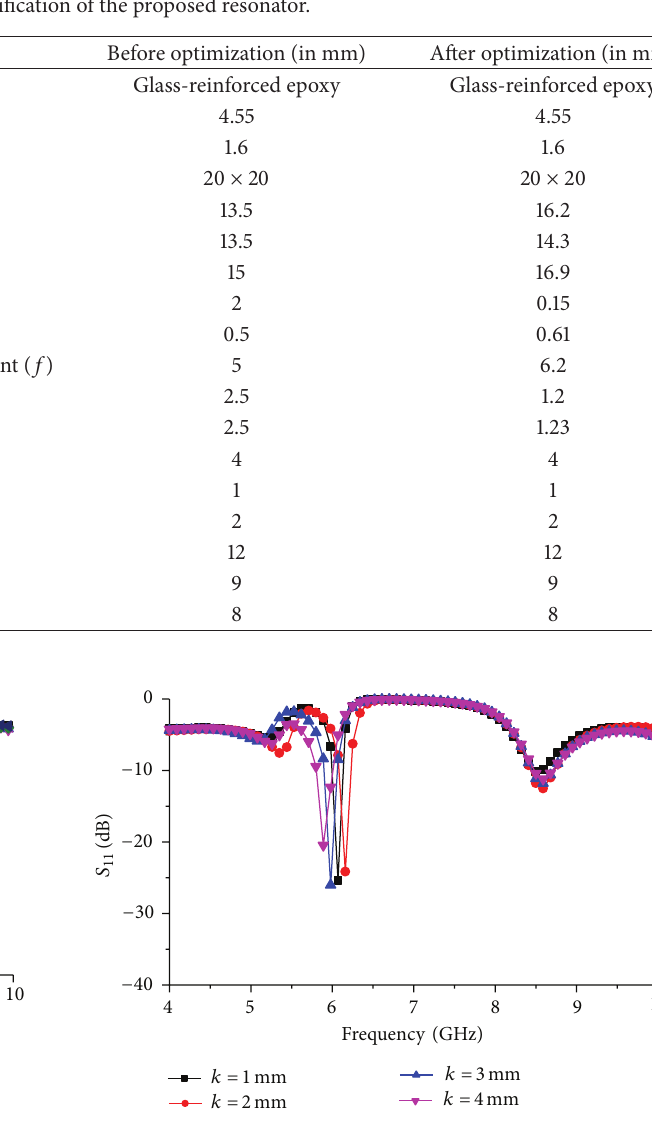
Figure 8: Resonator resonance response for change in length “ 𝑗 .”